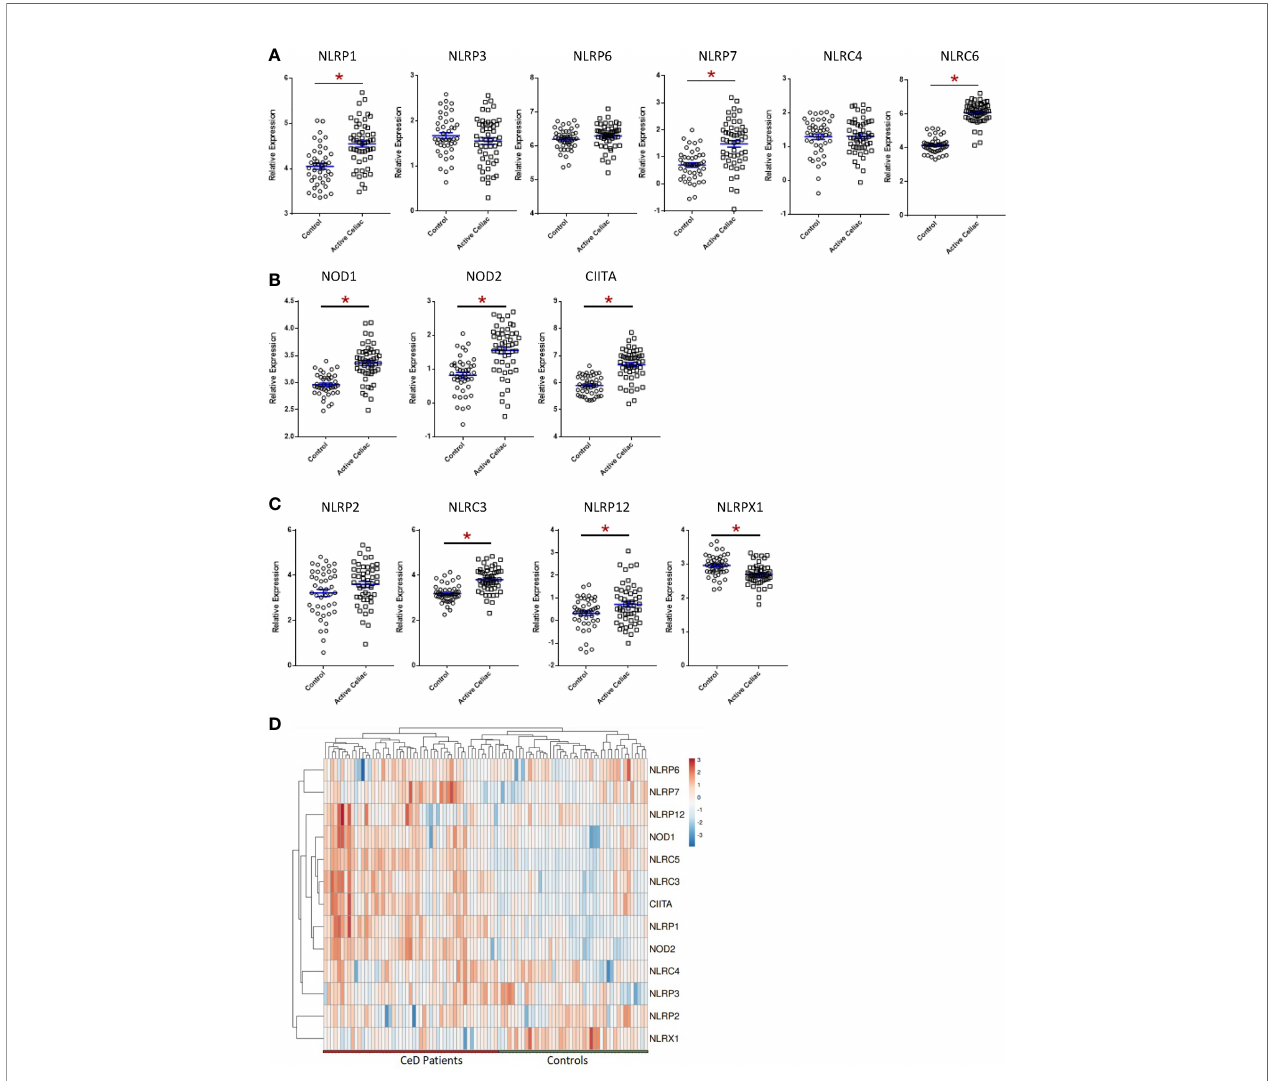
FIGURE 1 | Signi fi cant Dysregulation of NLR Signaling in Active CeD Patients. (A) In fl ammasome-forming NLR signaling trended higher in active CeD patients than controls, with signi fi cant variation observed in NLRP1, NLRP7, and NLRC5. (B) Gene expression of the regulatory NLRs NOD1, NOD2, and CIITA were signi fi cantly upregulated in active CeD patients. (C) Gene expression of the negative regulatory NLRs also trended higher in active CeD patients, with signi fi cant upregulation observed in NLRC3 and NLRP12. NLRX1 is the only negative regulatory NLR that was signi fi cantly downregulated. (D) Gene expression heatmap of assorted NLRs in CeD patients. * p <